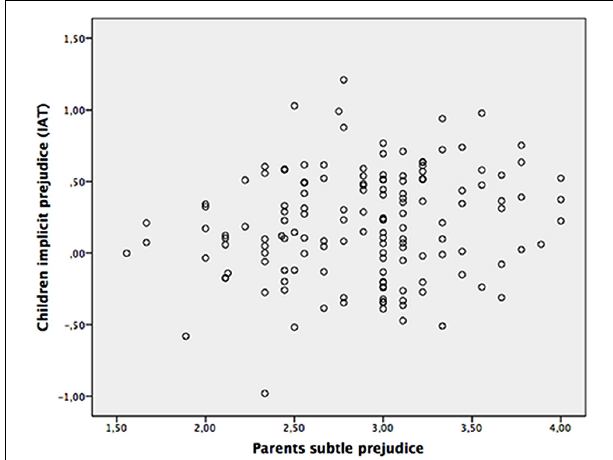
FIGURE 2 | Scatterplot of relations between parents blatant prejudice and children explicit prejudice.